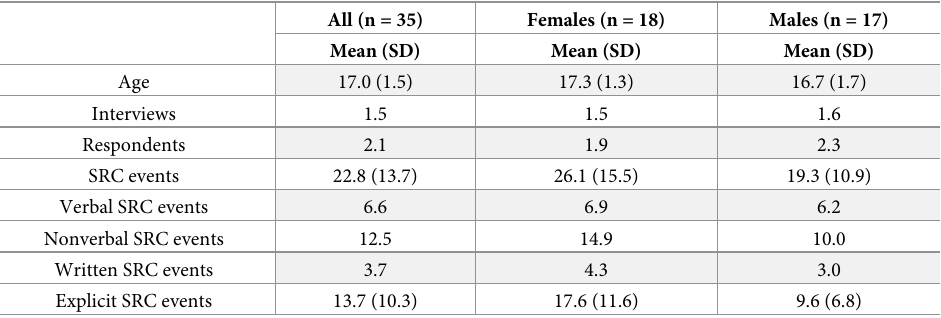
Table 1. SRC of sample